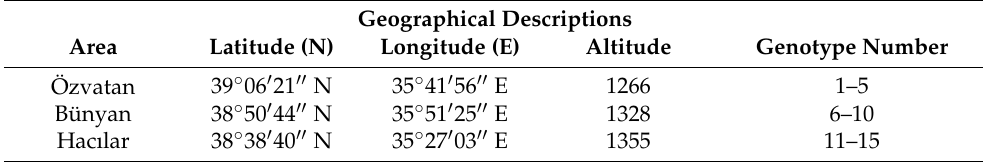
Table 1. Geographical description for the collection